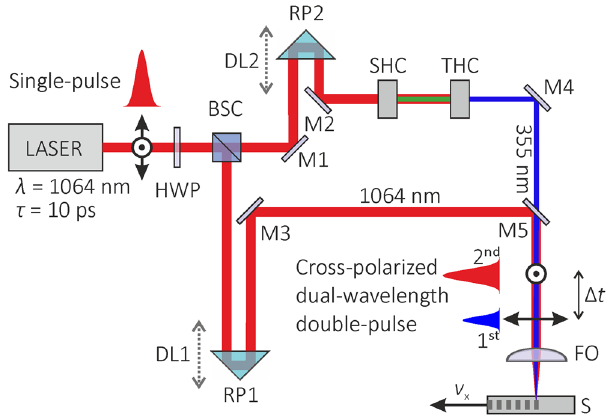
Figure 6. Experimental setup for the cross-polarized dual-wavelength double-pulse combined laser irradiation. LASER is the pulsed laser radiation source; HWP is the half-wave plate; BSC is the beam splitter cube; DL1 and DL2 are the delay lines with movable retro-reflection prisms RP1 and RP2; M1, M2, M3, and M4 are the high reflective mirrors; SHC is the second harmonic crystal; THC is the third harmonic crystal; M5 is the harmonic beam splitter mirror; FO is the focusing objective, S is a sapphire wafer sample, v x is the scanning speed of sapphire